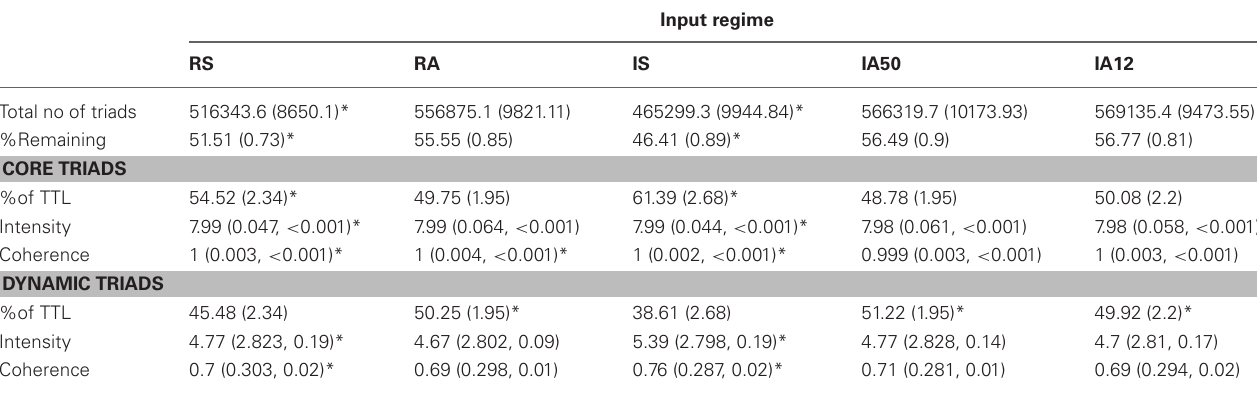
Table 1 | Core and dynamic triad characteristics by input